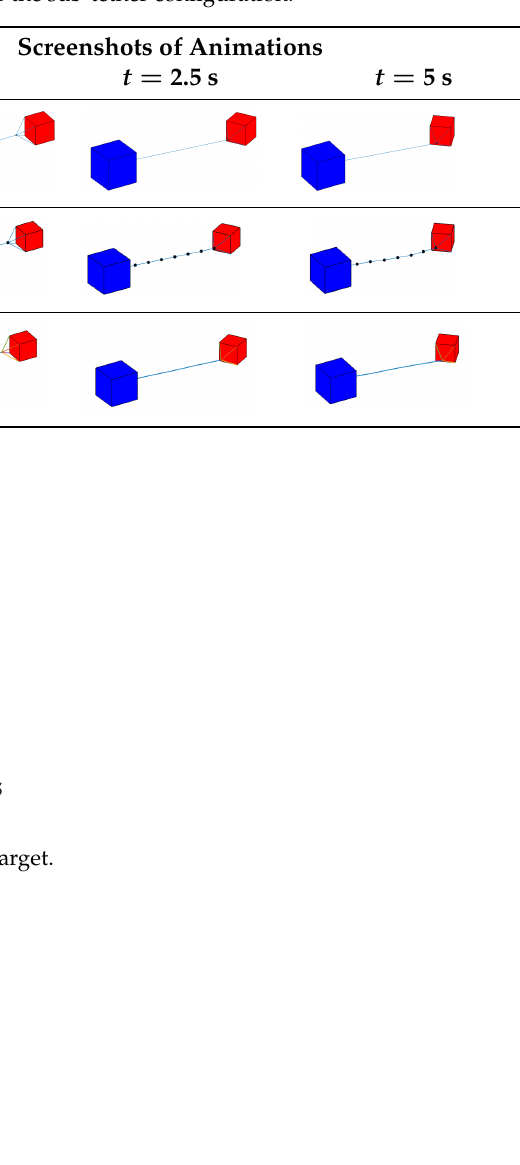
Table 3. Simulation animation screenshots for the sub-tether configuration.